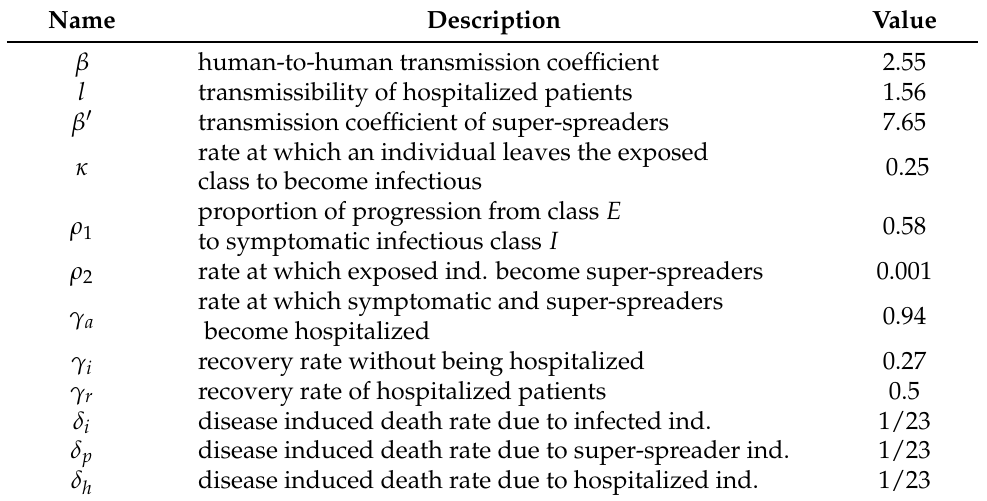
Table 1. Description and values of the parameters of Model (1) taken from [9,10].